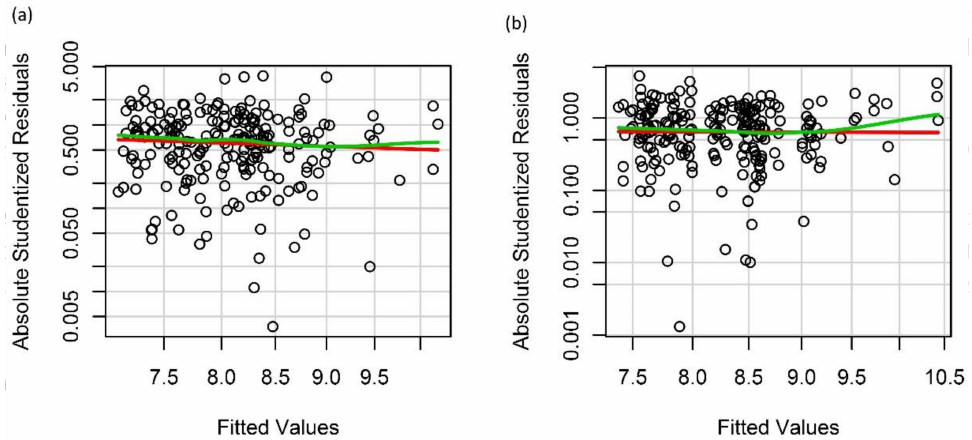
Figure 4. The plots of standardized residuals vs. fitted values for ( a ) regression model in Scenario 1 (S1); ( b ) regression model in Scenario 2 (S2). The red line shows the linear fit and the green line as less smooth